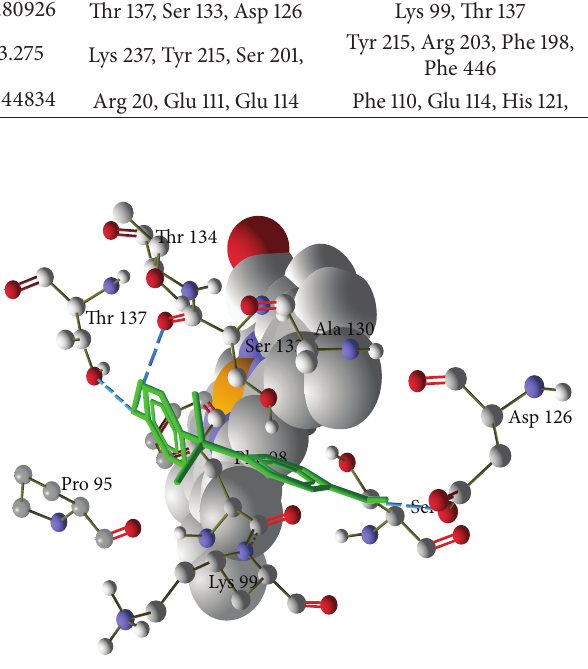
Figure 4: Hydrogen bond and steric interactions of human deoxy- haemoglobin (PDBid-2HHB) with bisphenol A. Green color is bisphenol A and whole structure is hemoglobin.